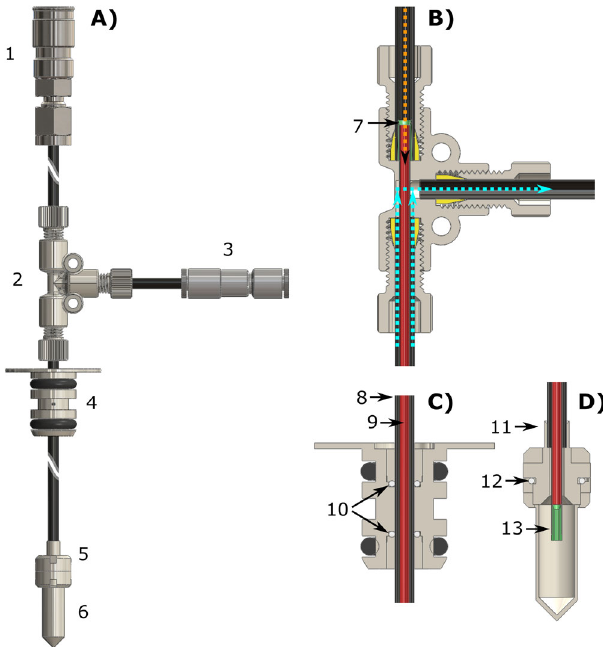
Fig. 1 Custom fl uid path (CFP) illustration. Technical drawings of the CFP ( A ) and zoomed section of the T-valve indicating inner (orange arrow) and outer (cyan arrows) fl ow directions ( B ), dynamic sealing ( C ), and sample threaded vial ( D ). Numbers indicate the most important components of the device: quick release connection (1), T-valve (2), one-way valve (3), dynamic sealing (4), vial top part (5), vial bottom part (6), outer-lumen to inner-lumen transition (7), black PEEK outer-lumen (8), red PEEK inner- lumen (9), dynamic sealing silicon O-ring (10), laser-welded joint (11), vial PTFE O-ring (12), nozzle